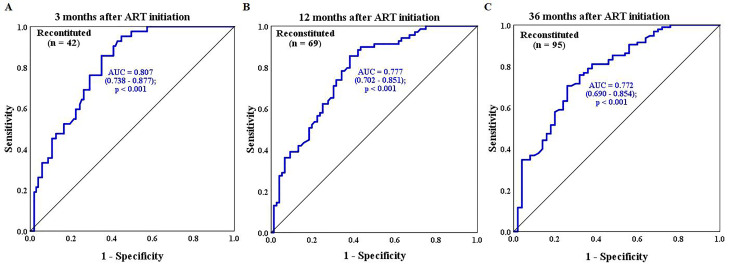
Receiver operating characteristic analysis.Sensitivity and specificity of the baseline CD4 T cell count for the development of immune reconstitution in human immunodeficiency virus-1 infected patients. (A)—Immune reconstitution in the first 3 months; (B) Immune reconstitution in the first year; and (C) Immune reconstitution at the end-point (36 months) of antiretroviral therapy (C). AUC–Area under the curve.